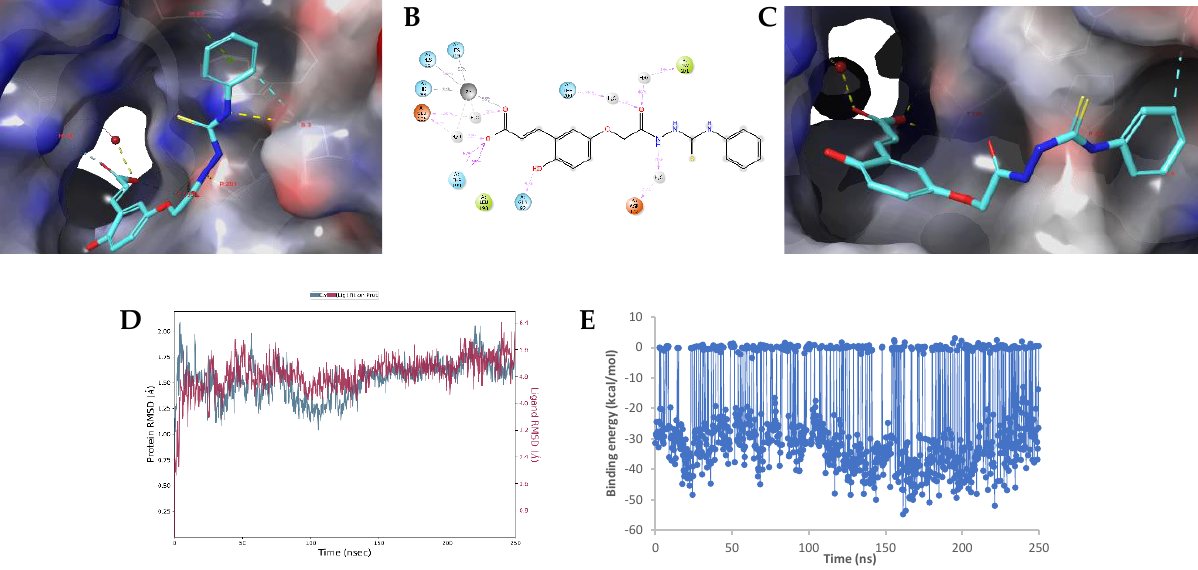
Figure 2. ( A ) The docked pose 14a-( E )-open . ( B ) Ligand–protein binding interactions observed for 30% or more of the duration of the unrestricted MD simulation. ( C ) Ligand pose after a 250 MD simulation. ( D ) RMSD value of the protein Cα -atoms and the ligand heavy atoms. ( E ) MM-GBSA binding energy. In the 2D plots, anionic residues are indicated in red, cationic residues are indicated in purple, hydrophobic residues and surfaces are indicated in green and hydrophilic residues and surfaces are indicated in light blue. Hydrogen bonds are indicated in purple (2D plots) or yellow ( A , C ) dashed lines.